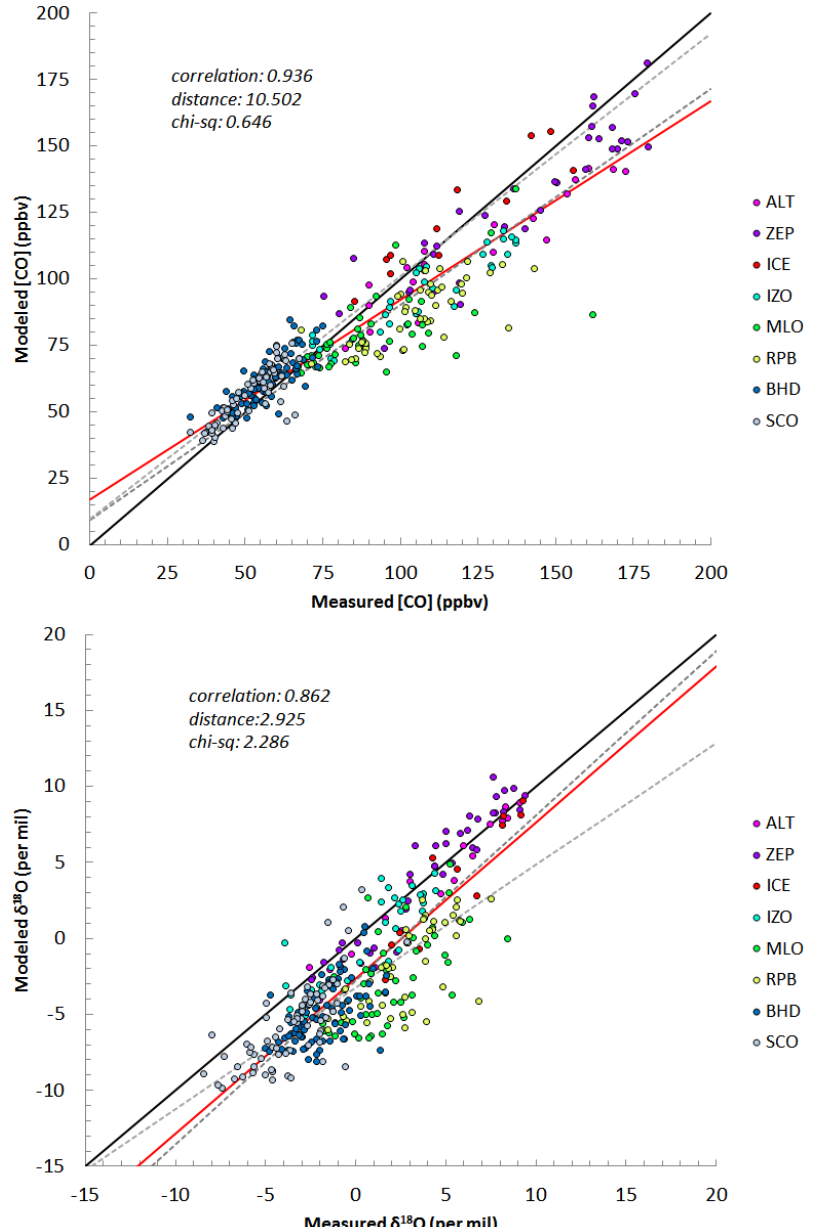
Figure 4. A scatter plot of measured versus modeled concentration of CO (upper panel) and measured versus modeled δ 18 O of CO (lower panel). The black solid line depicts 1:1 correspondence and the red line is a regression line of all measurements. The dotted lines are regression lines of the NH (dark gray) and the SH (light gray) data